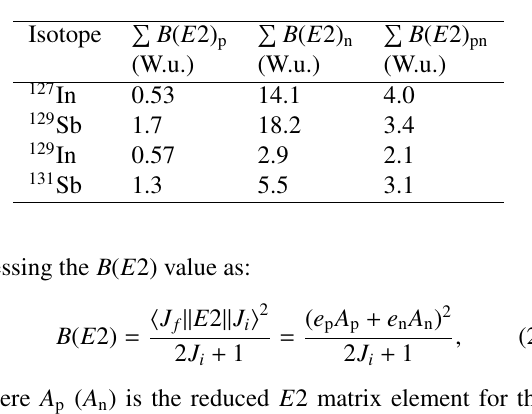
Table 6. Proton and neutron components of E 2